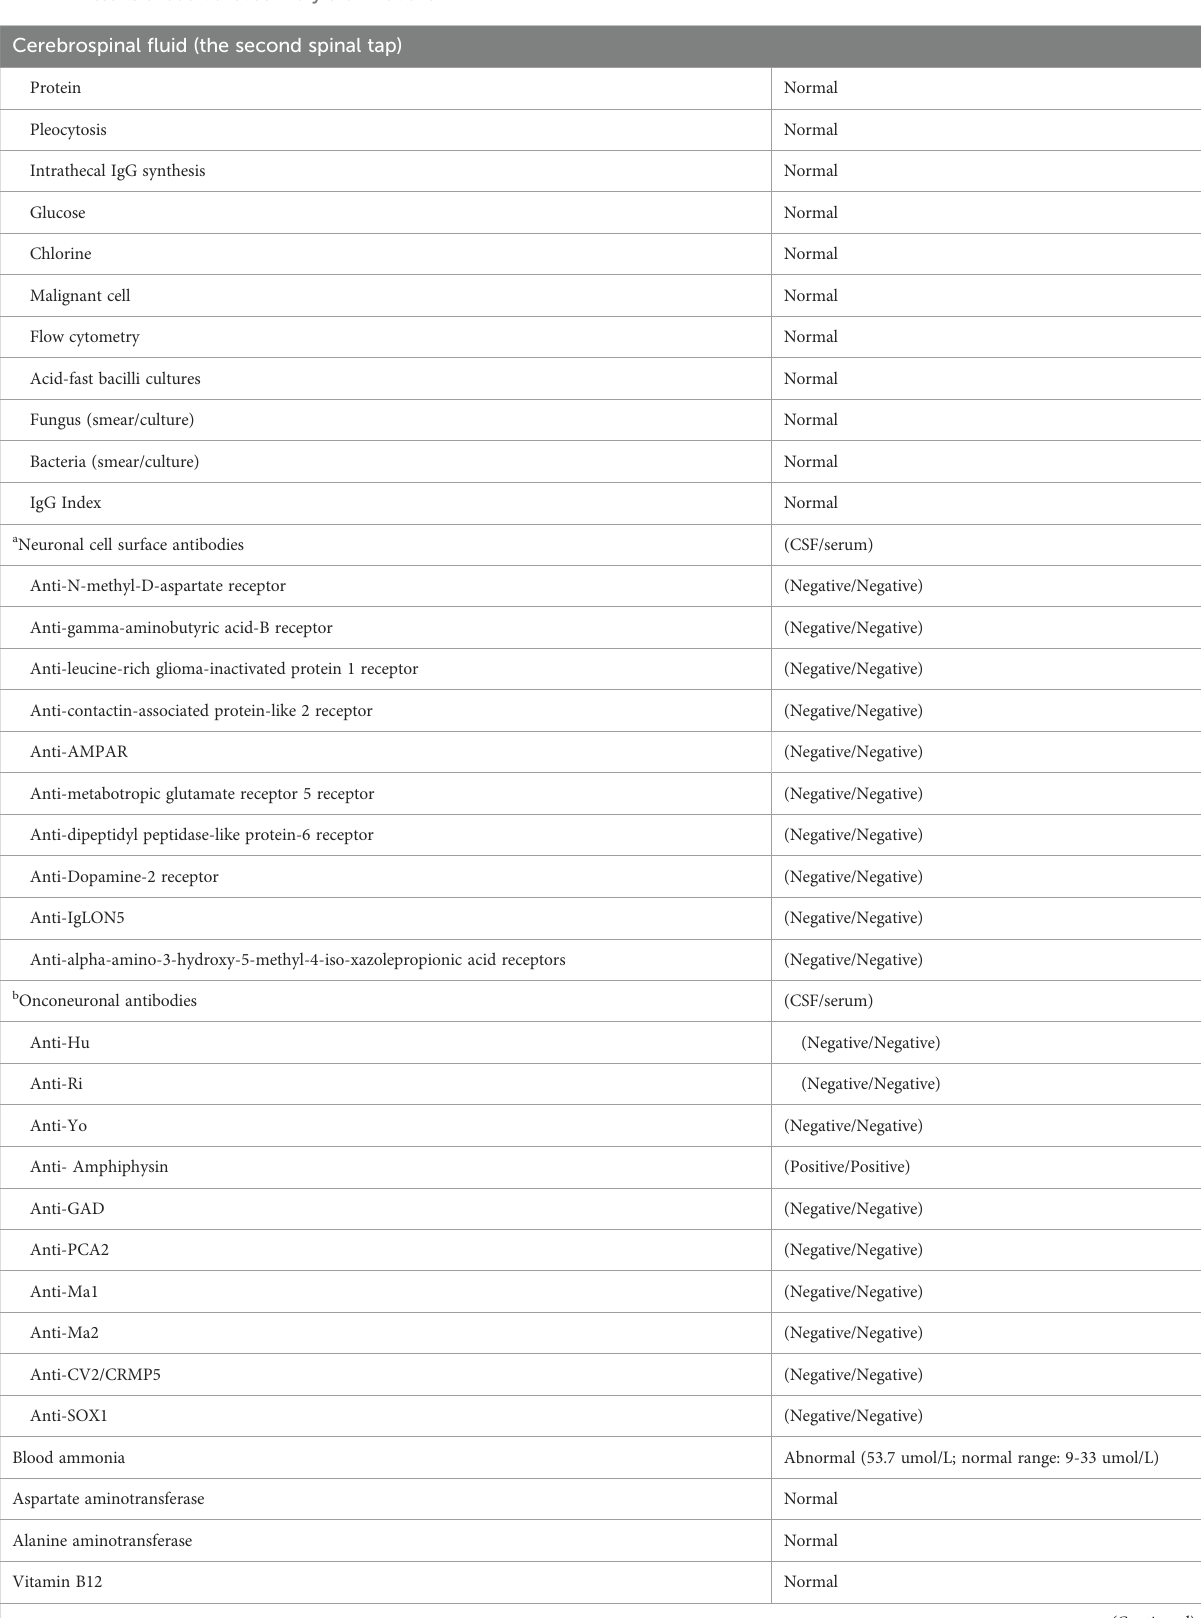
TABLE 1 Results of additional auxiliary